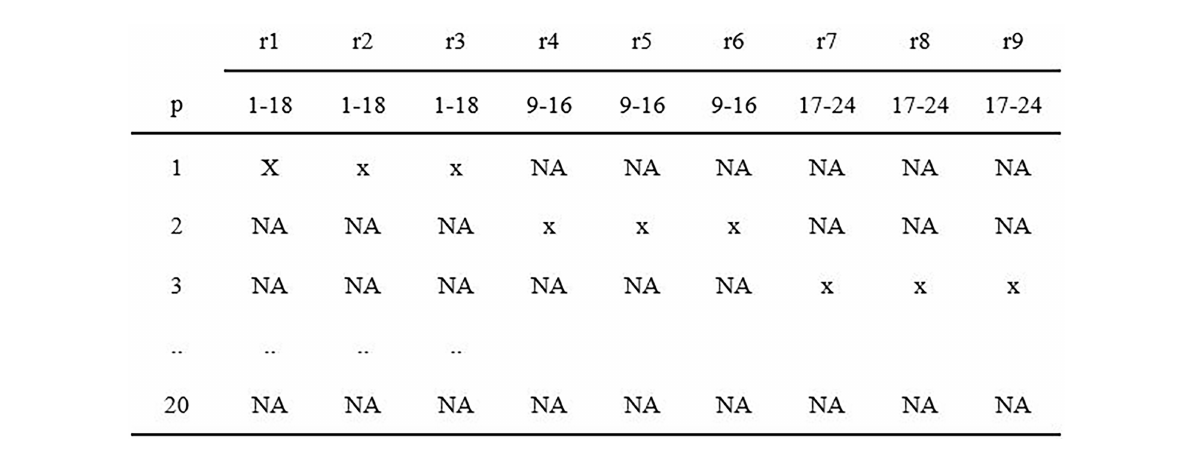
FIGURE 2 Exemplary representation of the dataset format for calculating the variance component decomposition (adapted from Jiang,